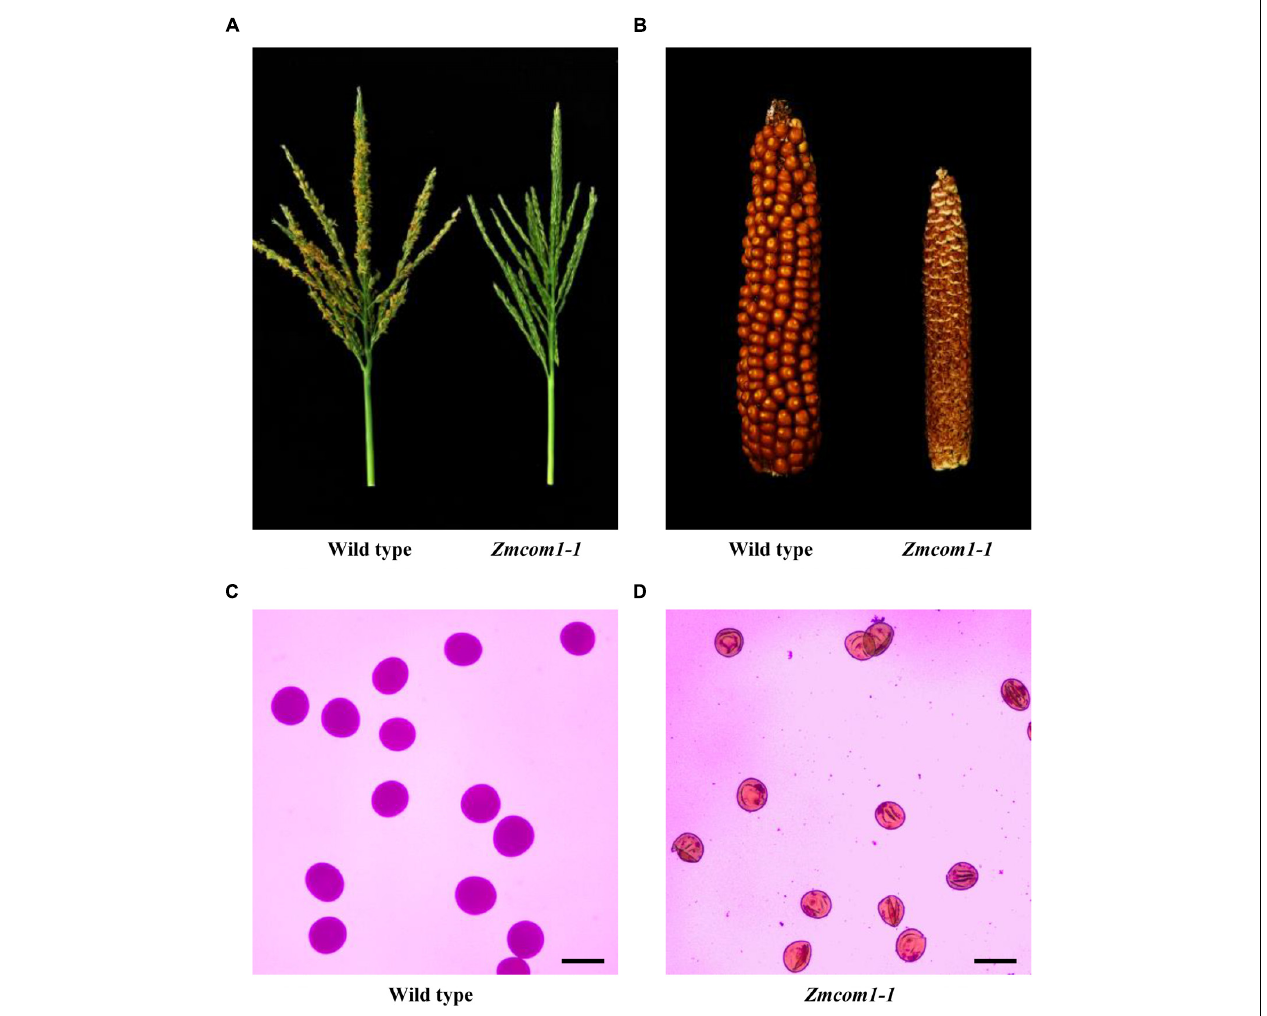
FIGURE 2 | Male and female sterility of Zmcom-1 mutant plants. (A) Comparison of a wild type tassel and a Zmcom1-1 tassel at the flowering stage. (B) Comparison of a wild type ear and a Zmcom1-1 ear. (C) Normal pollen grains of the wild type. Scale bar = 100 µ m. (D) Complete sterile pollen grains of the Zmcom1-1 plant. Scale bar = 100 µ